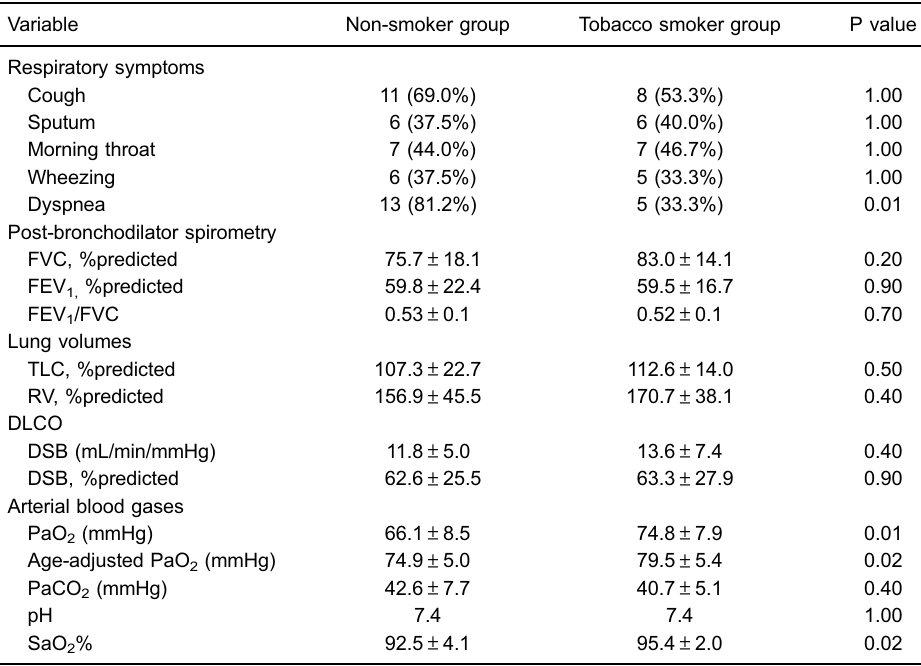
Table 2. Respiratory symptoms and pulmonary function tests according to chronic obstructive pulmonary disease groups.